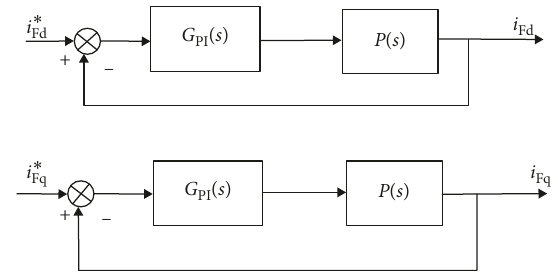
Figure 6: Fundamental current control block diagram based on PI controller.